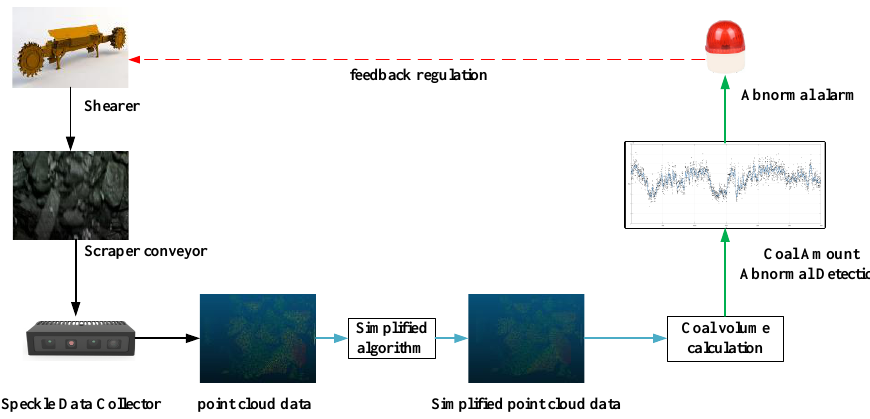
Figure 3. Technical route of coal flow monitoring research on scraper conveyor.